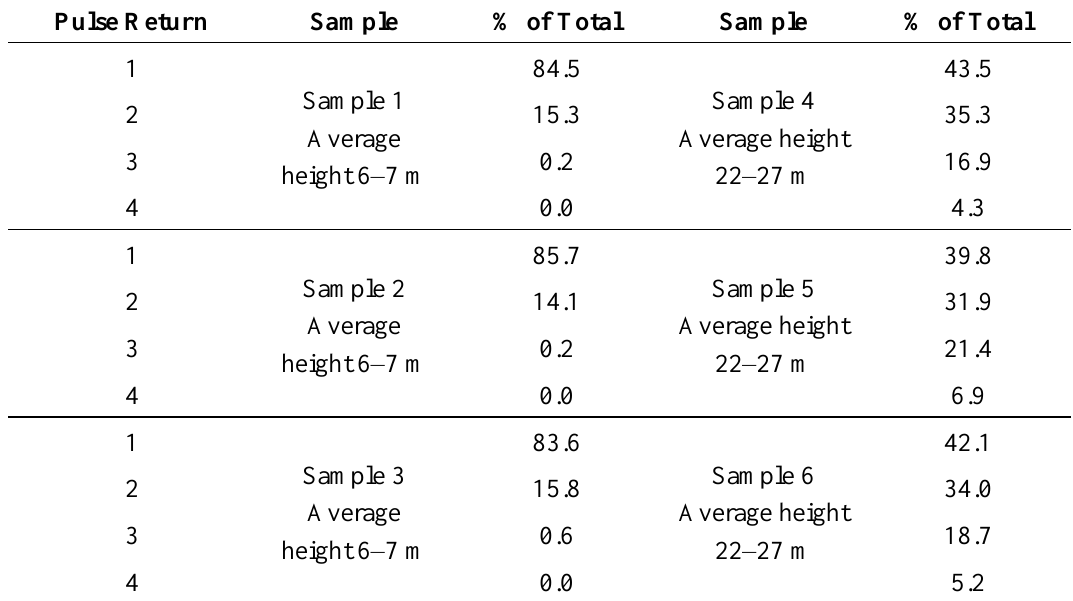
Table 5. ALTM-Gemini: Distribution of multiple returns for high and low-canopy vegetation. Pulse Return Sample % of